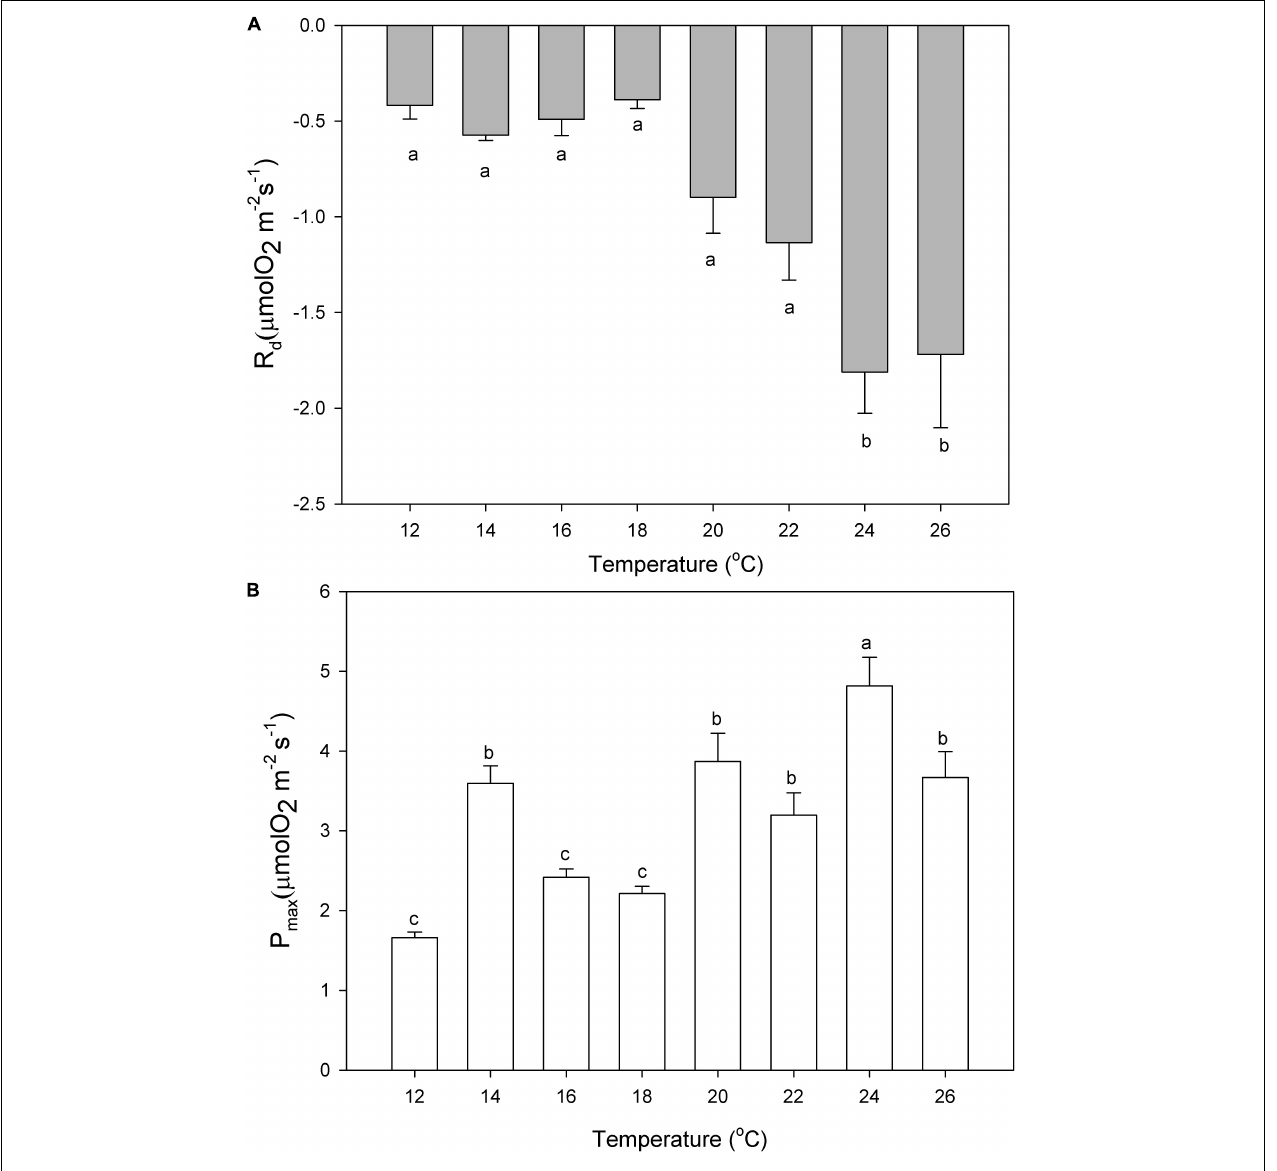
FIGURE 7 | Dark respiration (R d , A ) and maximum photosynthetic rates (P max , B ) of P. lusitanicum ( µ mol O 2 m − 2 s − 1 ) as a function of temperature. Different letters indicate significant differences. Mean values ± standard error (n =